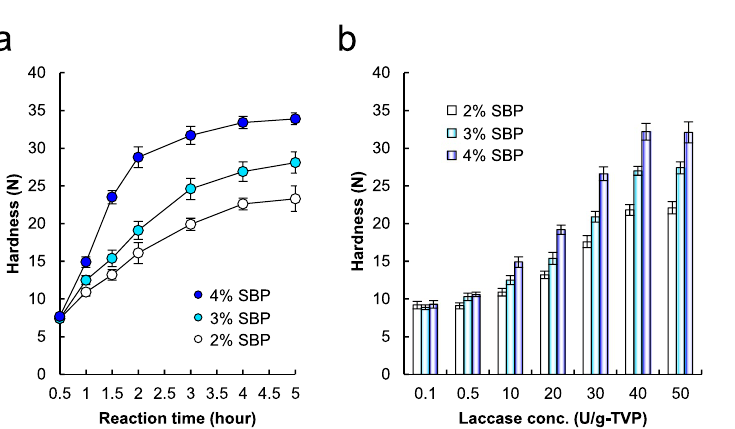
Figure 3. Hardness of grilled meat analog patties treated with LC. The hardness of the meat analogs treated with LC was measured using a rheometer. ( a ) Meat analogs containing 2–4% SBP were treated with 20 U/g-TVP LC at 0.5–4.0 h. ( b ) Meat analogs containing 2–4% SBP were treated with various concentrations of LC. Data are presented as mean ± standard deviation of five